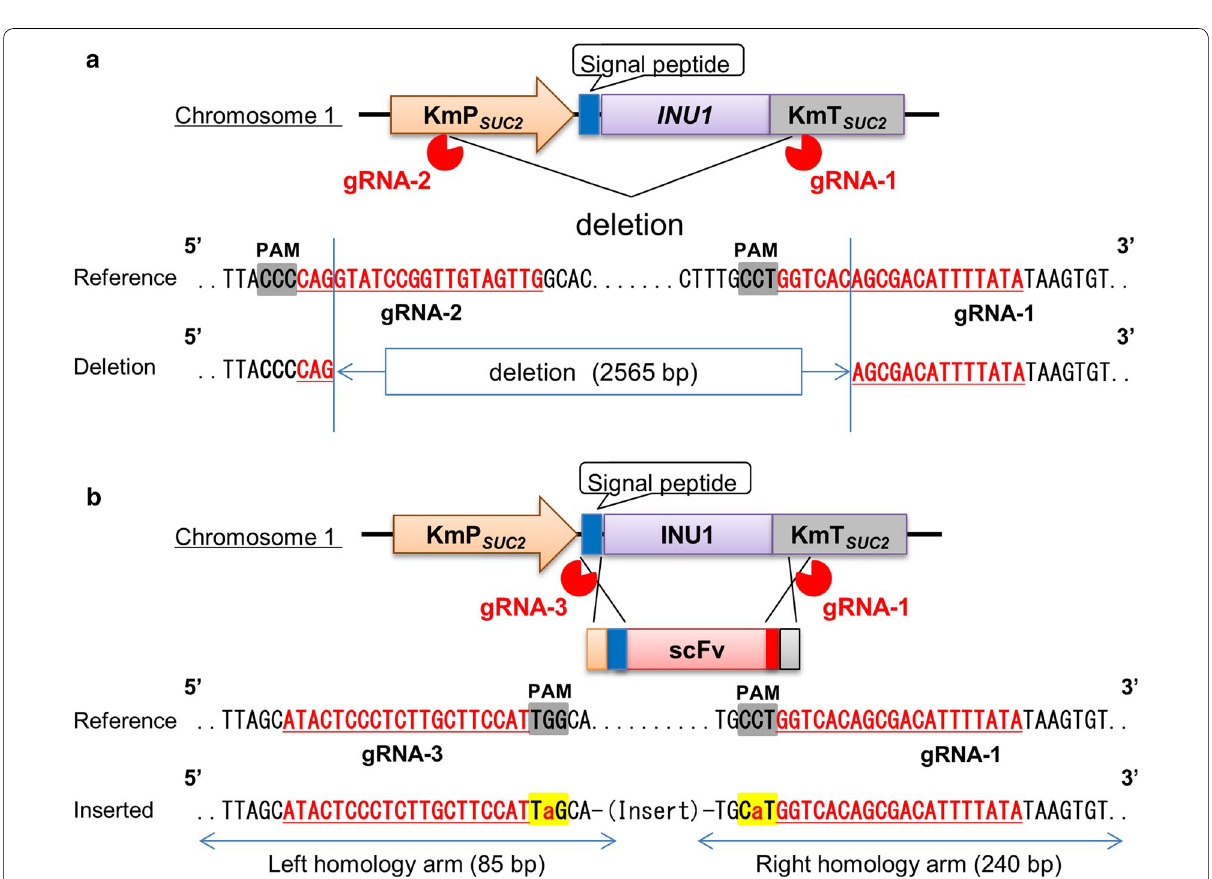
Fig. 1 Design of INU1 disruption and replacement. a A schematic of the INU1 locus and its deletion is shown. Reverse complement sequences of target (red) and PAM (shadowed) are shown on the reference sequence. The lower part of the panel shows an alignment of the sequence from the deletion strain with the sequence of the wild‑type locus. b A schematic of the INU1 replacement by a fragment encoding scFv is shown. The mutated PAM sequence and its reverse complement sequence are highlighted in yellow. Mutated bases are indicated as small red letters. The scFv‑ encoding fragment also encodes the INU1 secretion signal peptide (blue box) and a 6‑histidine tag (red box) in‑frame with the expressed